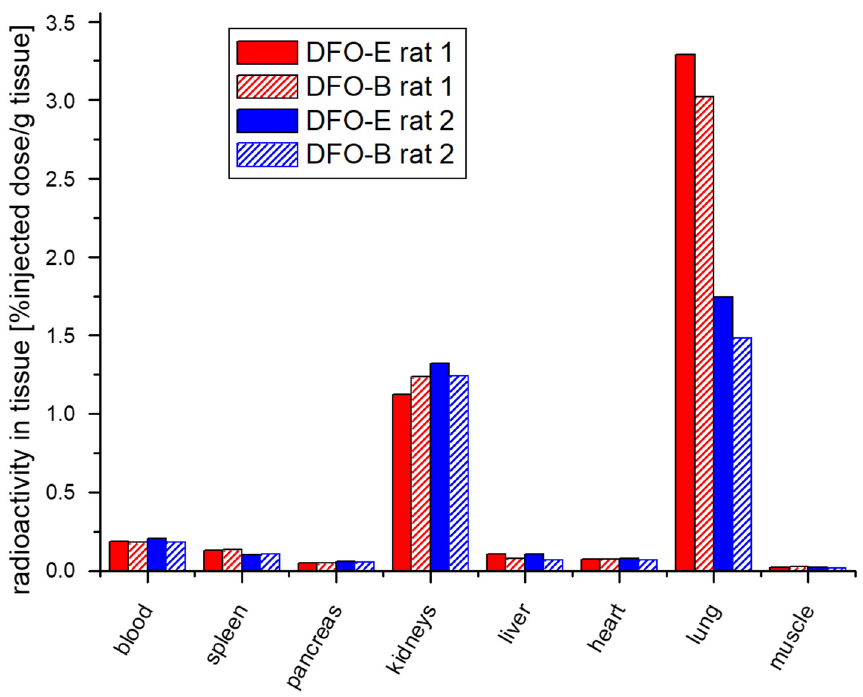
Figure 3. Comparison of the ex vivo biodistribution of radiolabeled DFO-B and DFO-E, respectively, expressed as % injected dose per organ.